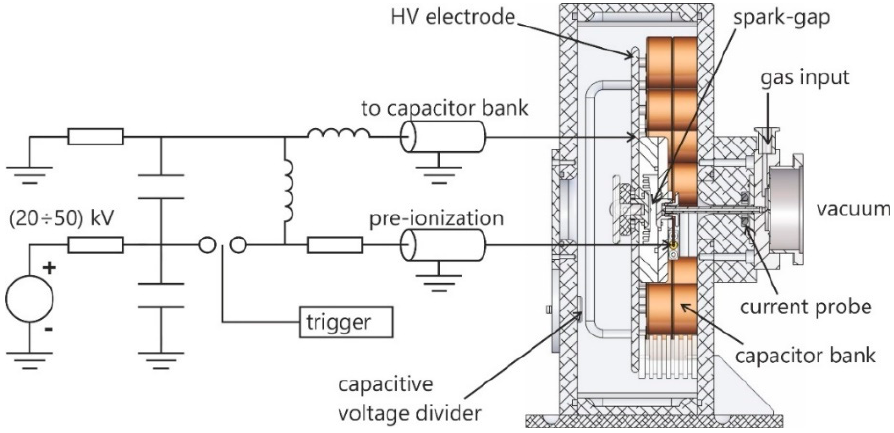
Figure 1. Schematic of capillary plasma driver and charging circuit.